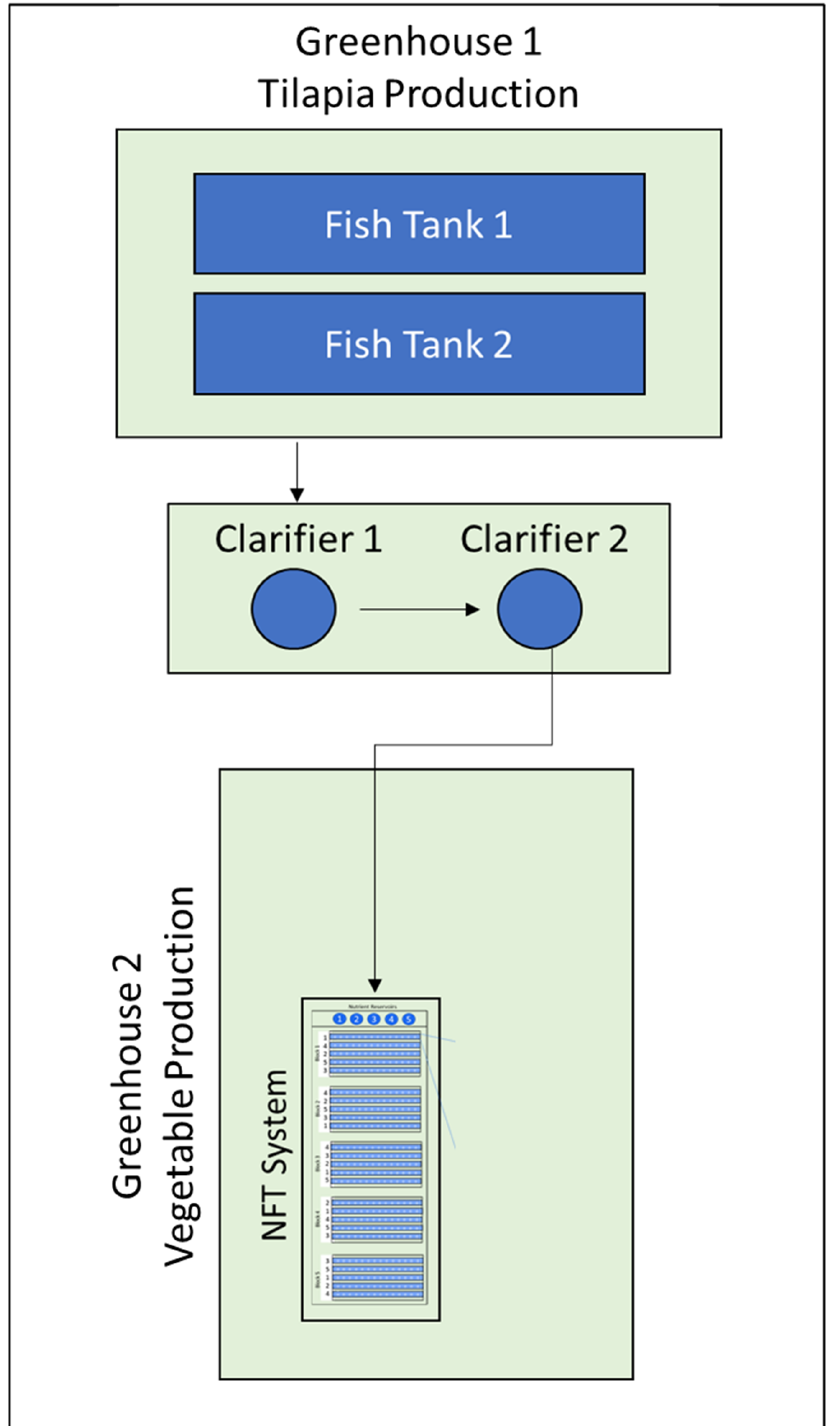
Figure 1. System. Overview. Water for hydraulic retention time trial was drawn from Fish tank 2 in this